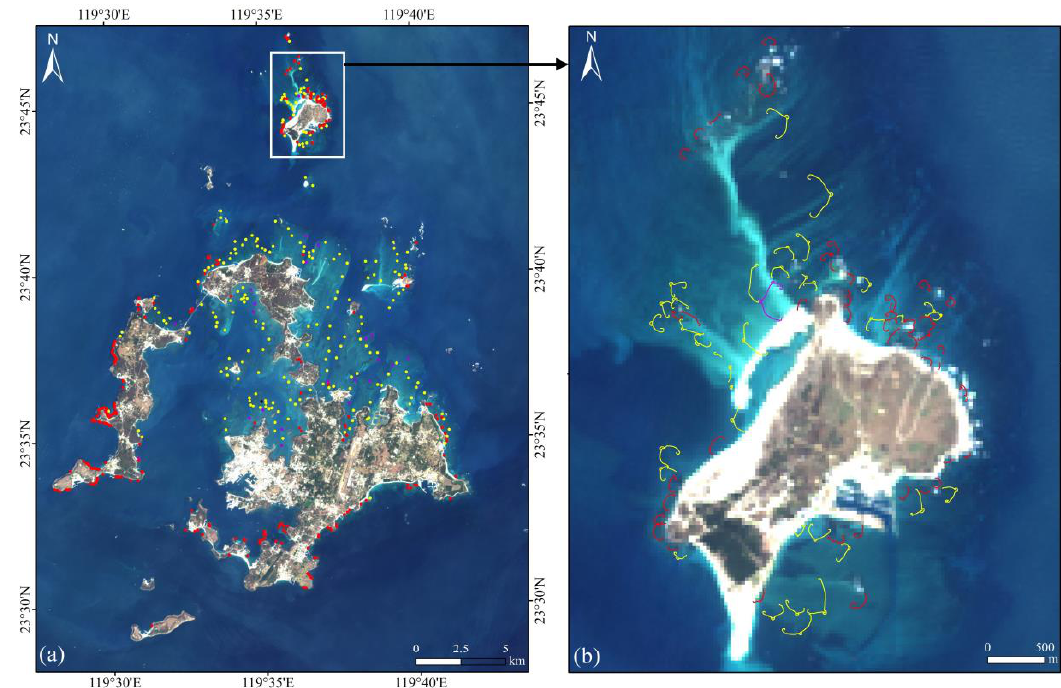
Figure 6. ( a ) Spatial distribution map of Stone Tidal Weirs (STWs)on Penghu Islands, China; ( b ) close-up image of ( a ) in Chipei Island. The red, yellow and violet represent the arched, single-room and double room STWs, respectively. (The base map is the Landsat-8 OLI image, which can be downloaded from http://www.usgs.gov).